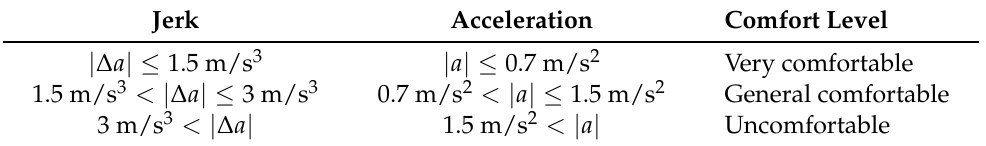
Table 2. Comfort levels for absolute jerk and acceleration values based on the reviewed